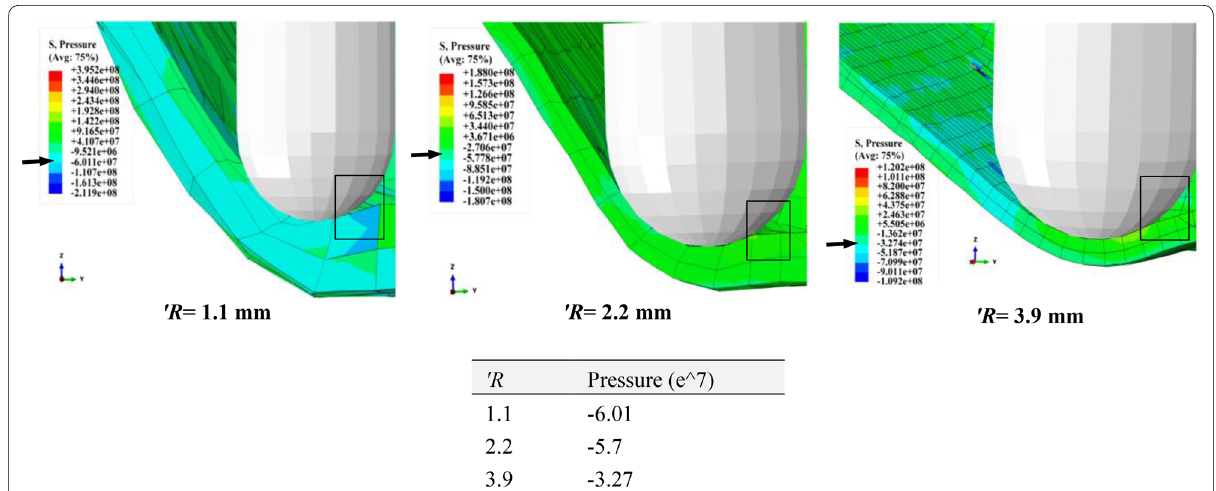
Figure 5 Pressure contours for three levels of normalized